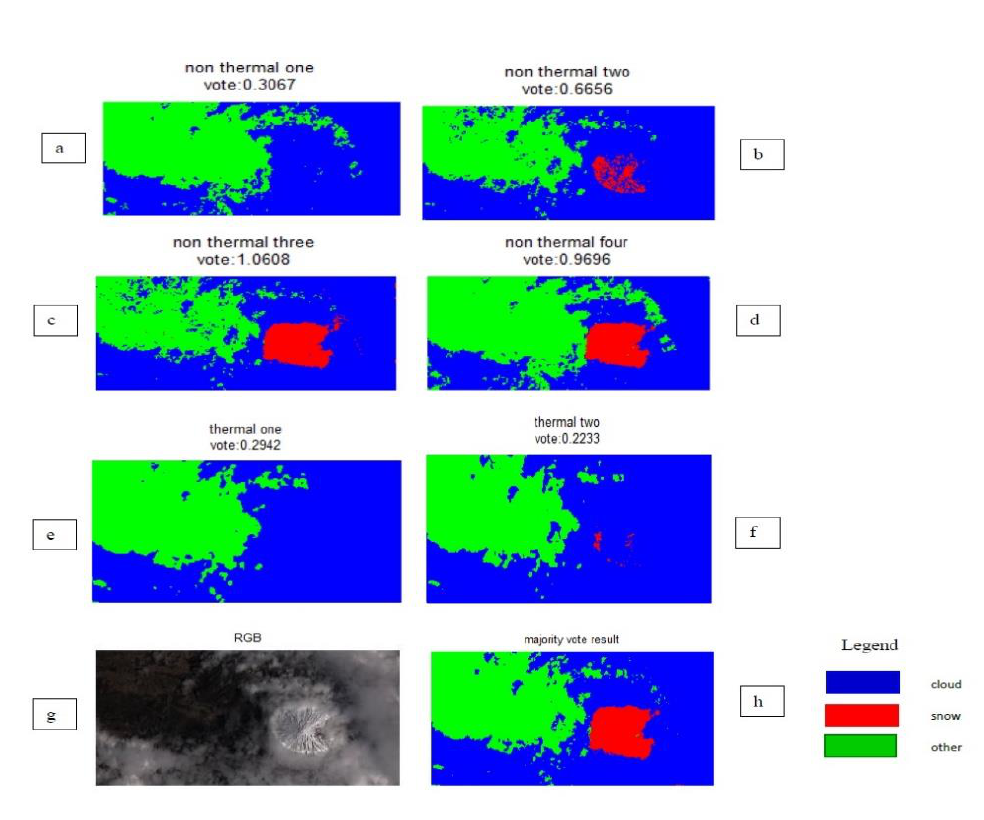
Fig. 5: a-f: classification results of each of weak classifiers .g: RGB image. h: fusion result